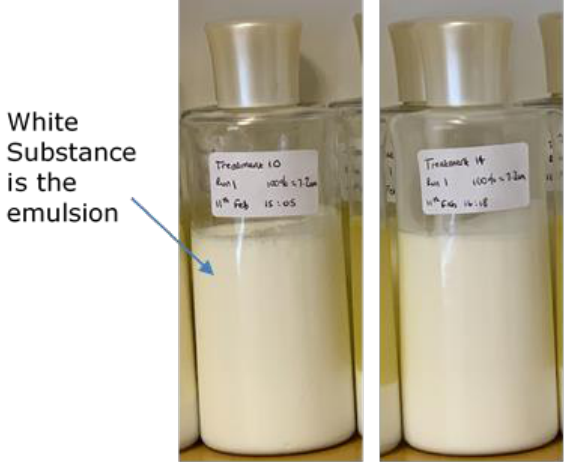
Figure 7. Treatments 10 and 14 displaying 100% stability after 14 days.